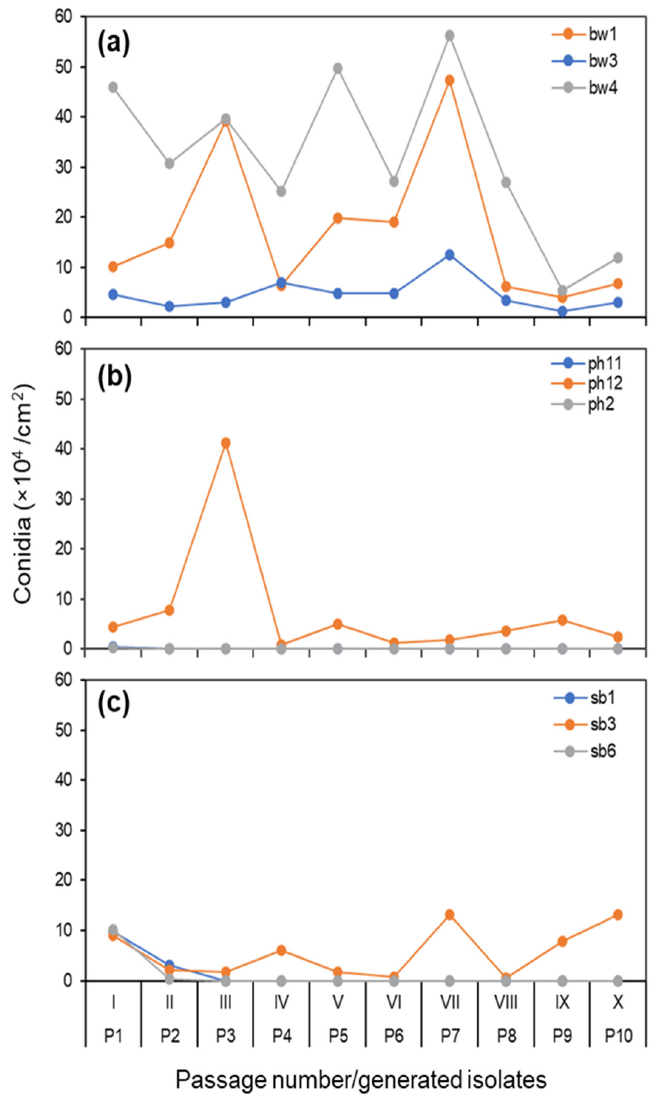
Figure 4. Conidia produced by Calonectria pseudonaviculata isolates on their plants of origin, i.e., boxwood ( a ), pachysandra ( b ), or sweet box ( c ), 4 weeks after inoculation in 10 passages (I–X). For each isolate, 10 detached leaves of an original host plant were inoculated with a drop of conidial suspension from a culture plate (P0) for passage I or from infected leaves of the previous passage I to IX for passages II–X. P1–P10 are the isolates generated in the individual passages. Each point represents an average of six counts ( n = 6) of conidia collected from the infected